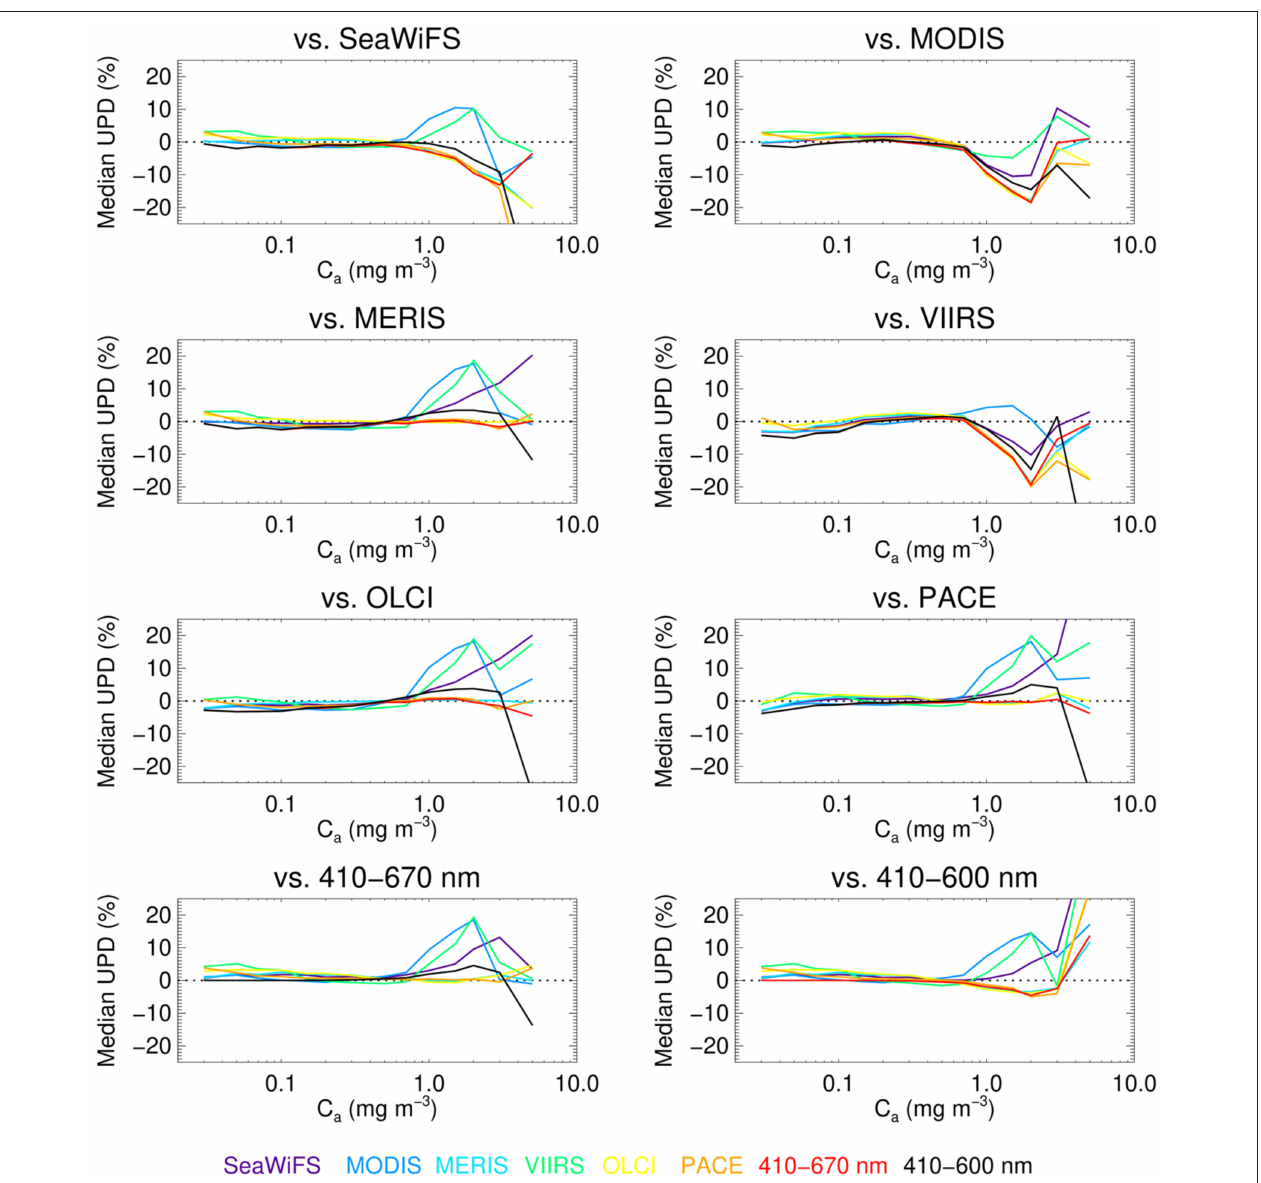
FIGURE 3 | Satellite-to-satellite median UPD for a (443) at each C a interval. Each panel title refers to the reference satellite to which the others are compared (satellite 1 in Equation 7). Each comparative satellite (satellite 2 in Equation 7) maintains a unique color: SeaWiFS (violet), MODIS (blue), MERIS (cyan), VIIRS (green), OLCI (yellow), PACE (orange), 410-670nm (red), and 410-600 nm (black).